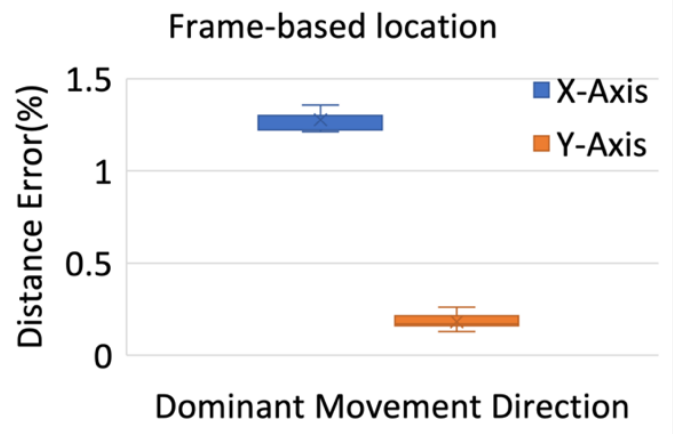
Figure 9. Boxplot of accuracy of frame-based location identification.